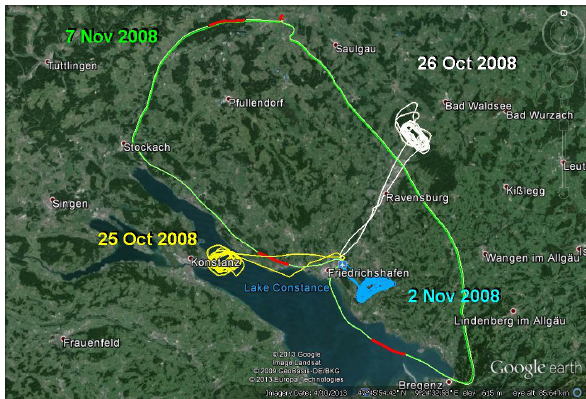
Fig. 1. Tracks of the five flights during which the whole air samples were collected; in the flight track of 7 November 2008 the sampling times are marked in red. 26